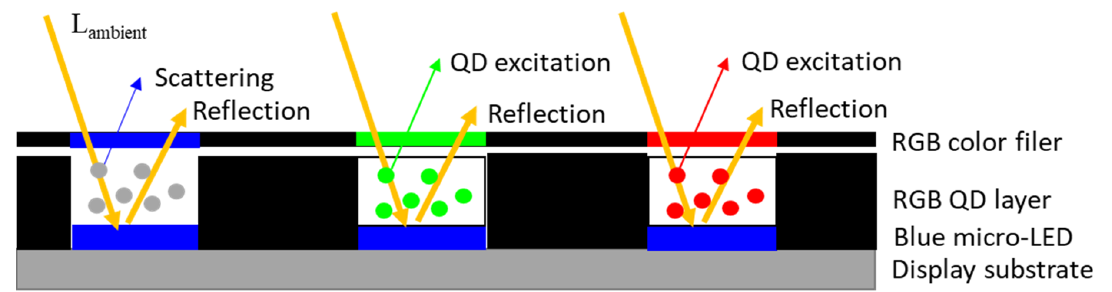
Figure 5. Device structure of our color-converted micro-LED display.